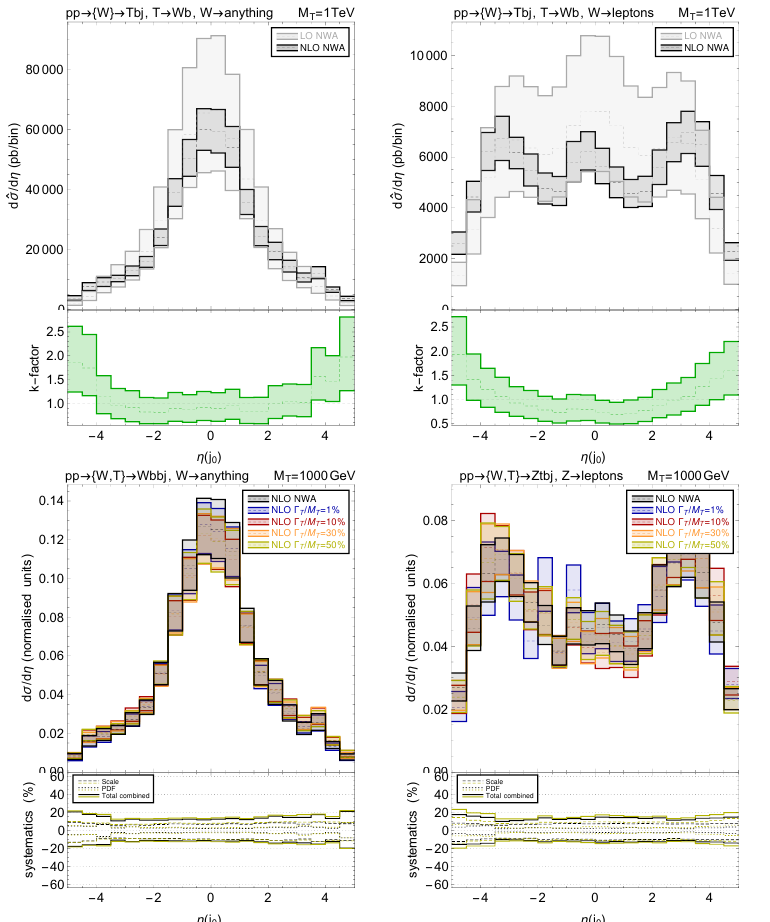
Figure 16 . Distributions of the pseudo-rapidity of the leading jet for single T production in association with a jet. We fix m = 1000 GeV and we consider the pp → { W, T } → Wbbj channel T when the W -boson decays inclusively (left) or leptonically (right). We refer to figure 13 for the description of the presented